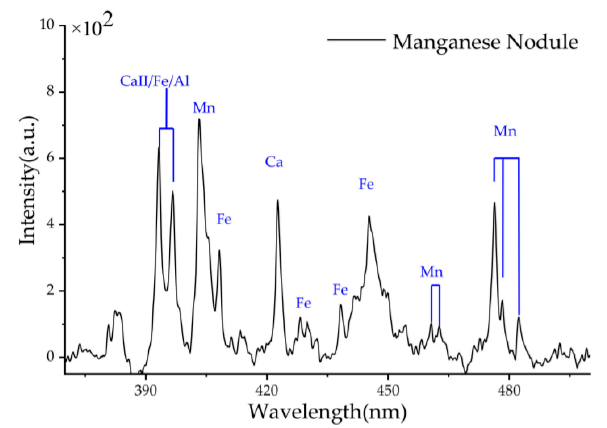
Figure 15. Typical LIBS spectra of a manganese nodule sample from deep sea in Jiaozhou Bay, China [138]. Table 4. Comparison of seawater composition determined by in situ determination by LIBS probe and analysis of the samples in the vicinity by ICP-AES in a laboratory [137].